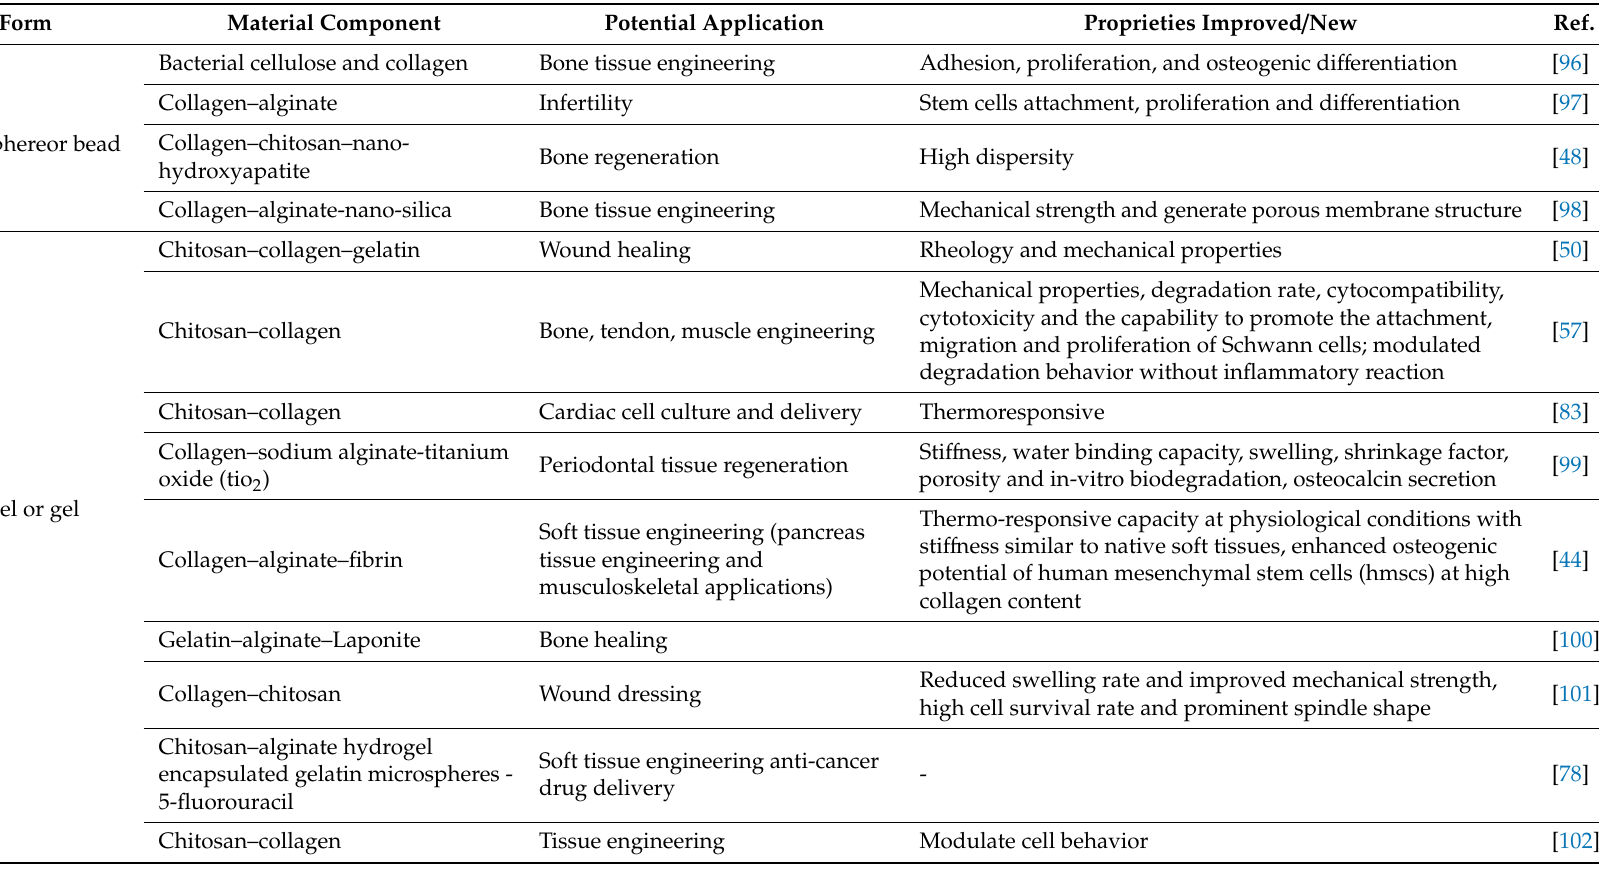
Table 3. Tissue repair and engineering